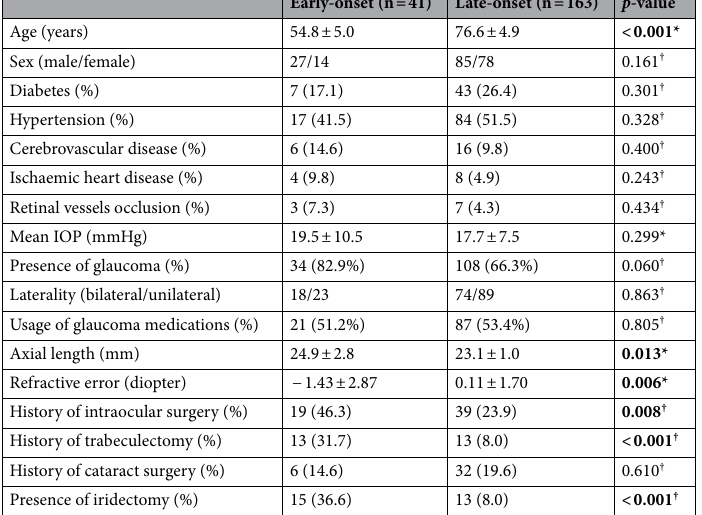
Table 1. Comparison of characteristics between patients with early-onset and late-onset XFS. Data are presented as mean ± standard deviation or frequency (%). IOP, Intraocular pressure; XFS, exfoliation syndrome. * p-value was calculated using the Mann–Whitney U test. † p -value was calculated using the chi- squared test or Fisher’s exact test. Statistically significant values are shown in bold.